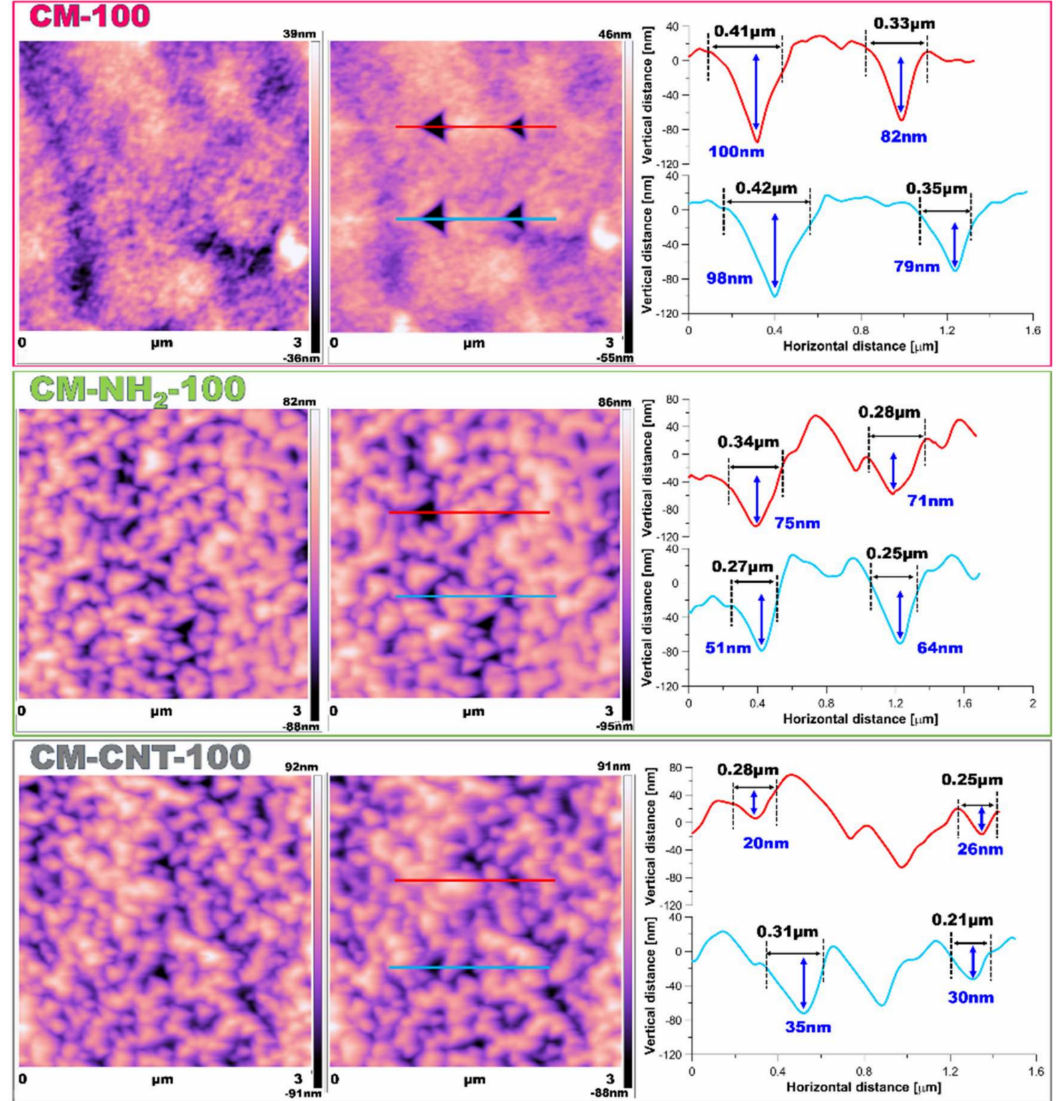
Figure 11. Nano-indentation test for pristine and modified samples of 100 nm membranes.